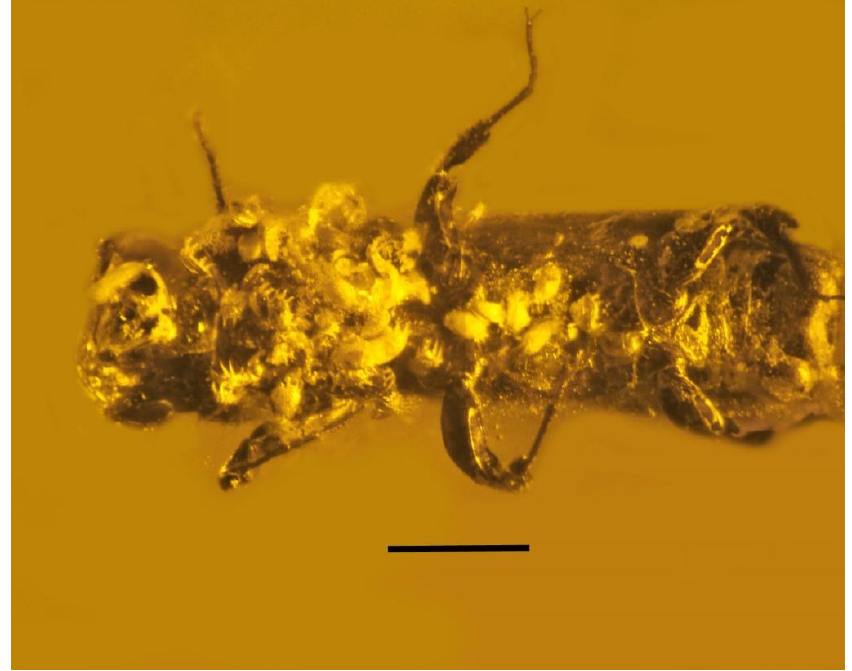
Figure 1. Mites (Arachnida: Acari) clinging to the underparts of a platypodine beetle (Coleoptera: Curculionidae: Platypodinae) in Dominican amber. Scale bar = 30 µm.